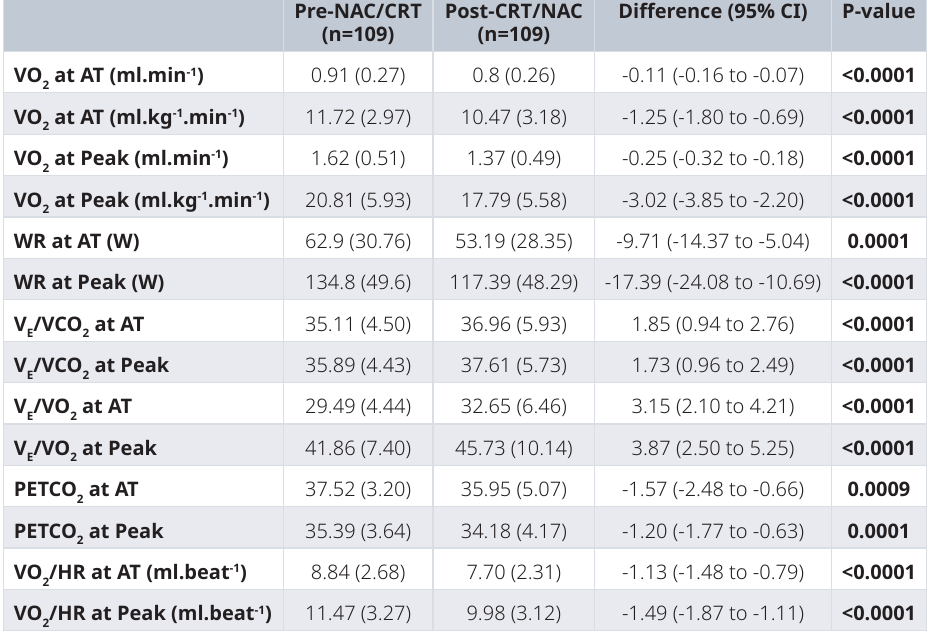
(Figure 7). A weak relationship between change in fitness risk group and survival at one year was noted (Better HR=0.78, 95%CI: 0.17 to 3.48; Worse HR=0.53, 95%CI: 0.17 to